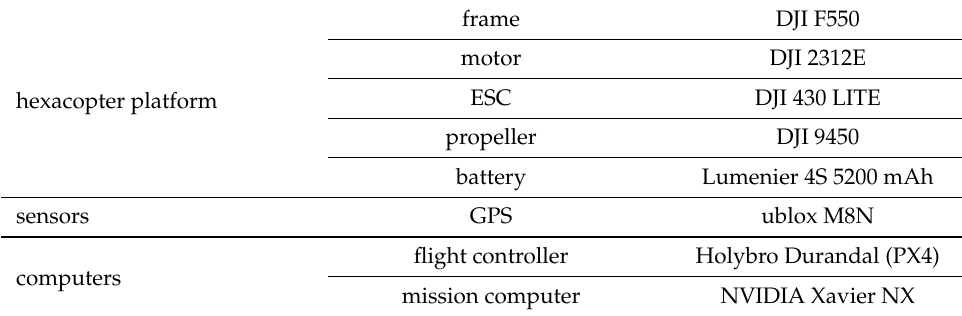
Figure 11. Outdoor experiment environment and quadrotor hardware platforms. Table 3. Hardware